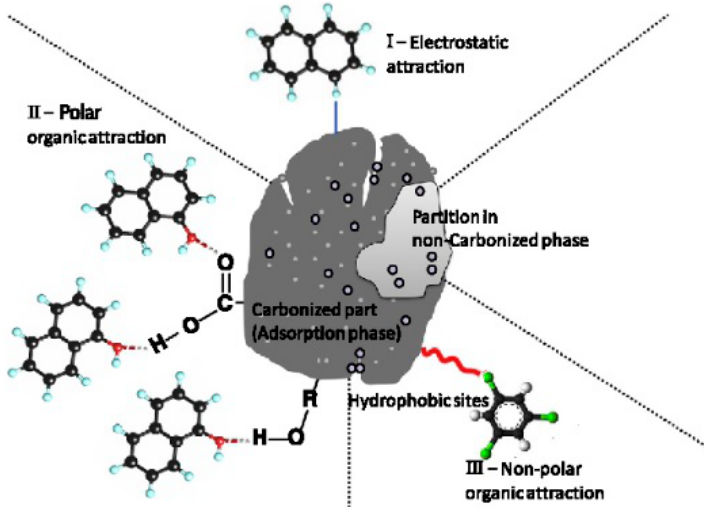
Figure 2. Mechanisms of organic substance adsorption on the surface of carbonization products [124].